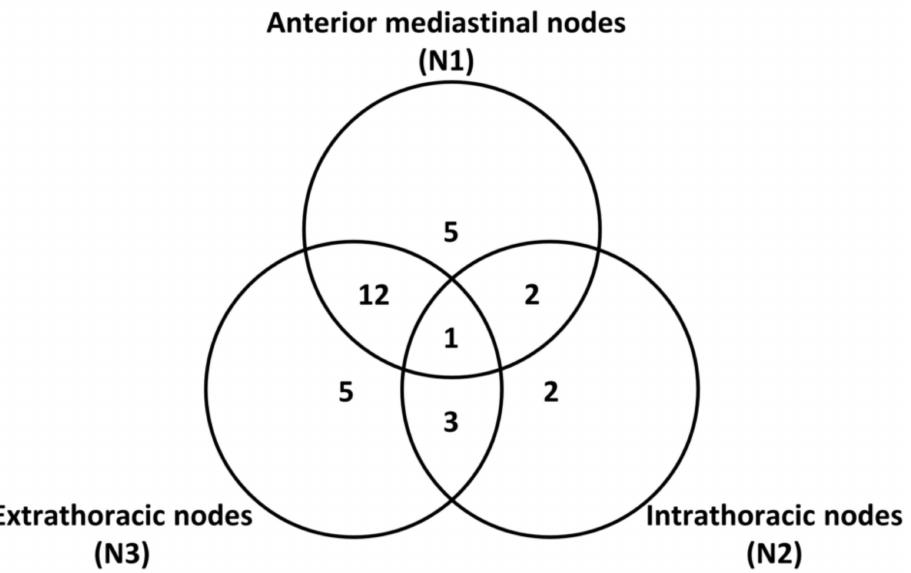
Figure 2. Patterns of nodal involvement at initial diagnosis ( n = 30). Anterior mediastinal nodes (N1), intrathoracic nodes (N2), and extrathoracic nodes (N3).